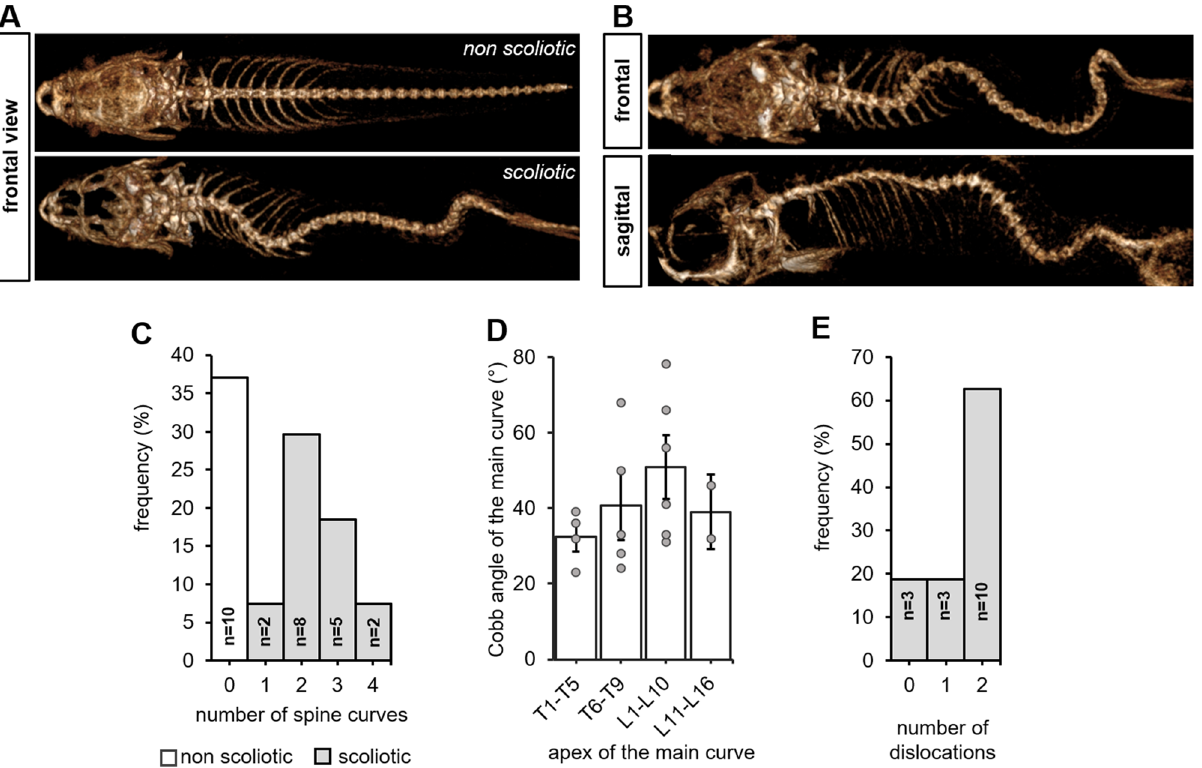
Figure 2. Juvenile cfap298 tm304/tm304 zebrafish mutants develop an evolutive thoraco-lumbar curvature of the spine. ( A ) Frontal views of scannographic reconstructions of 8-week-old non-scoliotic (top) and cfap298 tm304 scoliotic sibling (bottom). ( B ) Frontal and sagittal view of the same cfap298 tm304 scoliotic fish after scannographic reconstruction showing a 3-dimensional torsion of the spine reminiscent of AIS. ( C ) Distribution of the frequency of the number of spine curves observed in the sagittal plane of scoliotic (grey) and non-scoliotic (white) animals. The population analyzed was raised from a cross of cfap298 tm304/ + with cfap298 tm304/tm304 . Most of cfap298 scoliotic animals display double or triple curves in the frontal plane. ( D ) Distribution of the Cobb angle of the main curve in cfap298 scoliotic fish depending on the localization of the apex of the main curve. Bars represent the average Cobb angles ± SEM. Each point represents a single fish. Most of the main curve apices are located between T6 and L10 (11 out of 17 fish) ( E ) Histogram showing the distribution of the number of dislocations observed in the scoliotic population (frequency,